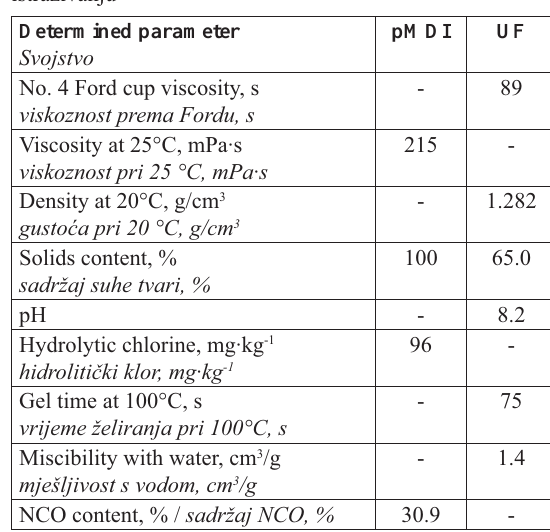
Table 1 Properties of liquid pure resins used in the